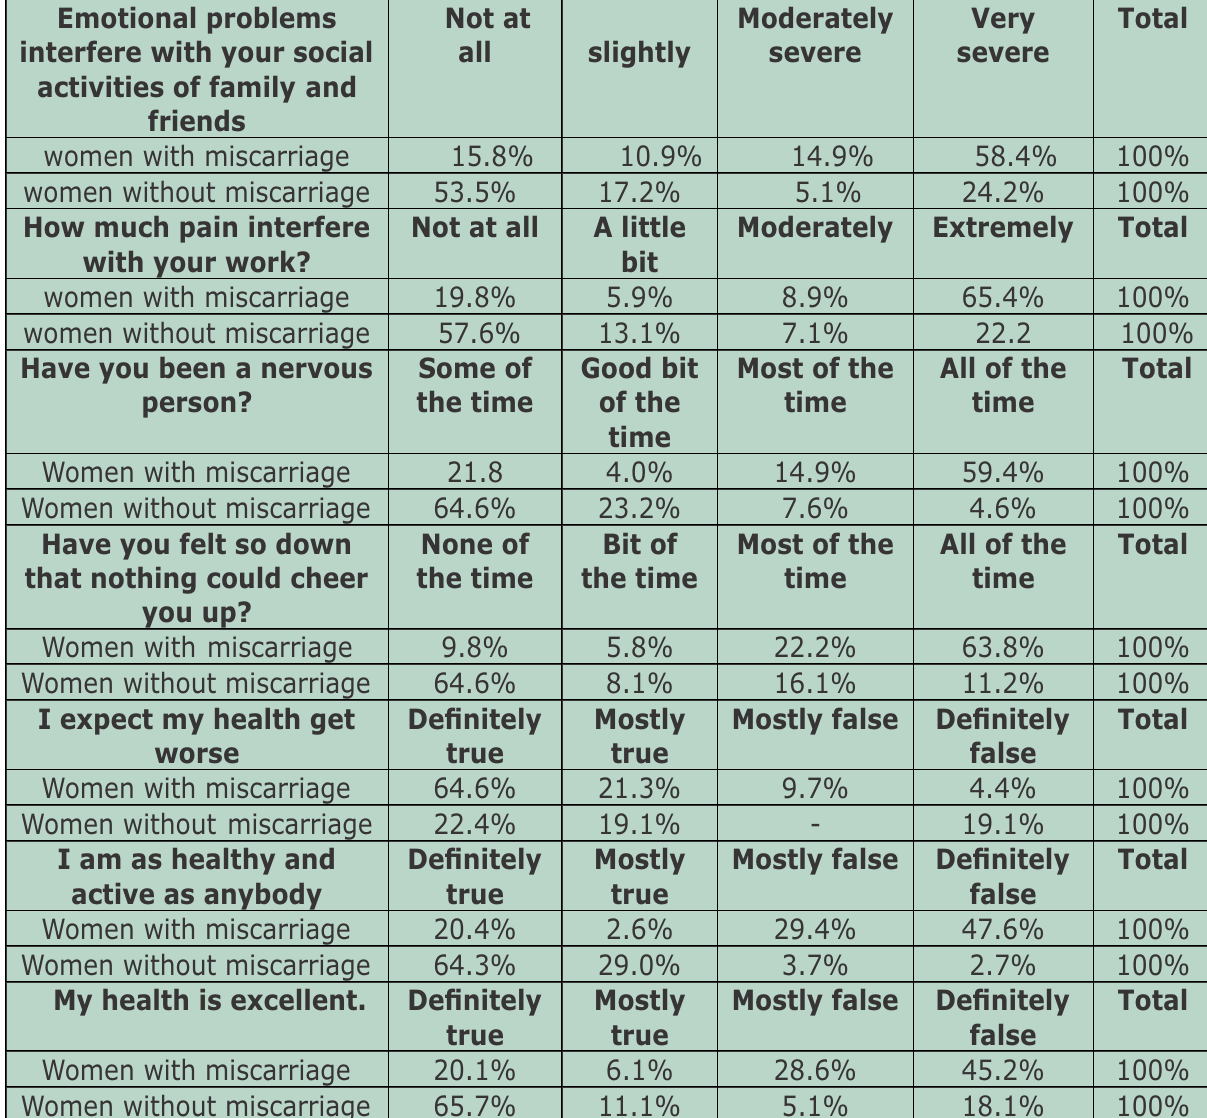
Table III: Comparison of Quality of life among women with and without